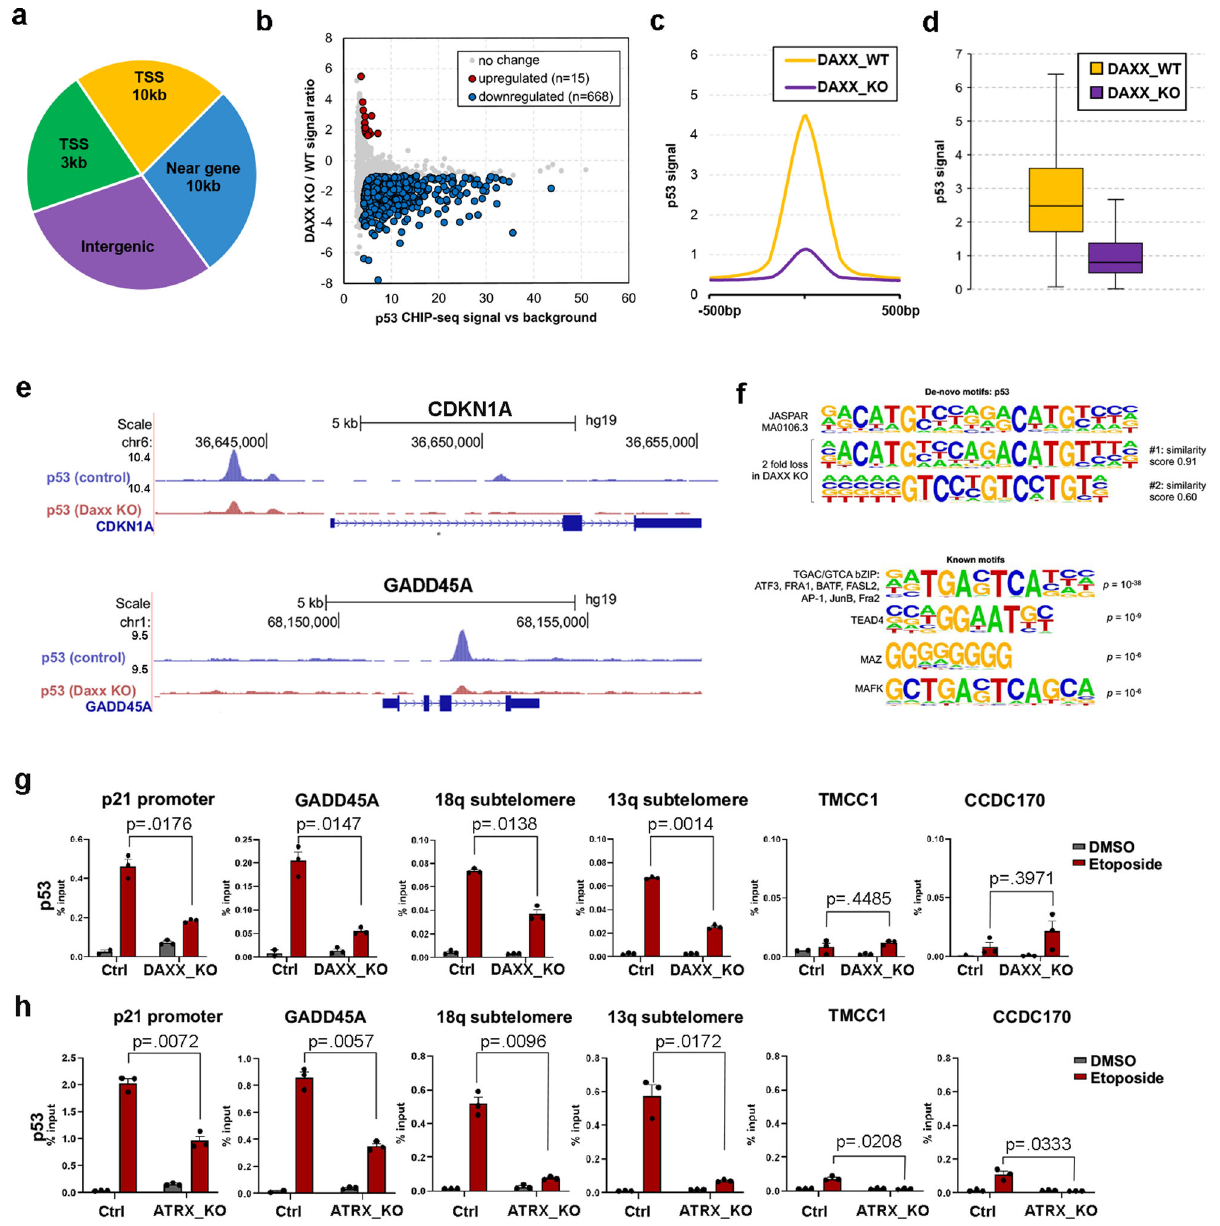
Fig. 4 | Attenuation of p53 chromatin binding in DAXX_KO and ATRX KO U87 cells.a Distributionof p53peakswithingene context. b Downregulated (blue)and upregulated (red) p53 ChIP-seq peaks in DAXX KO relative to WT cells ( y axis) as a function of p53 ChIP-seq intensity ( x axis). There is a trend of p53 being down- regulatedwithonlyfewupregulatedpeaksthatareoflowerChIP-seqsignal. c Mean p53 signal pro fi le comparison in DAXX KO vs WT condition among the set of downregulated peaks. d Box plot of the distribution of p53 signal between DAXX KOand WTconditionsamong the set of downregulated peaks. Whiskersrepresent maximum and minimum values and box represent upper quartile, median and